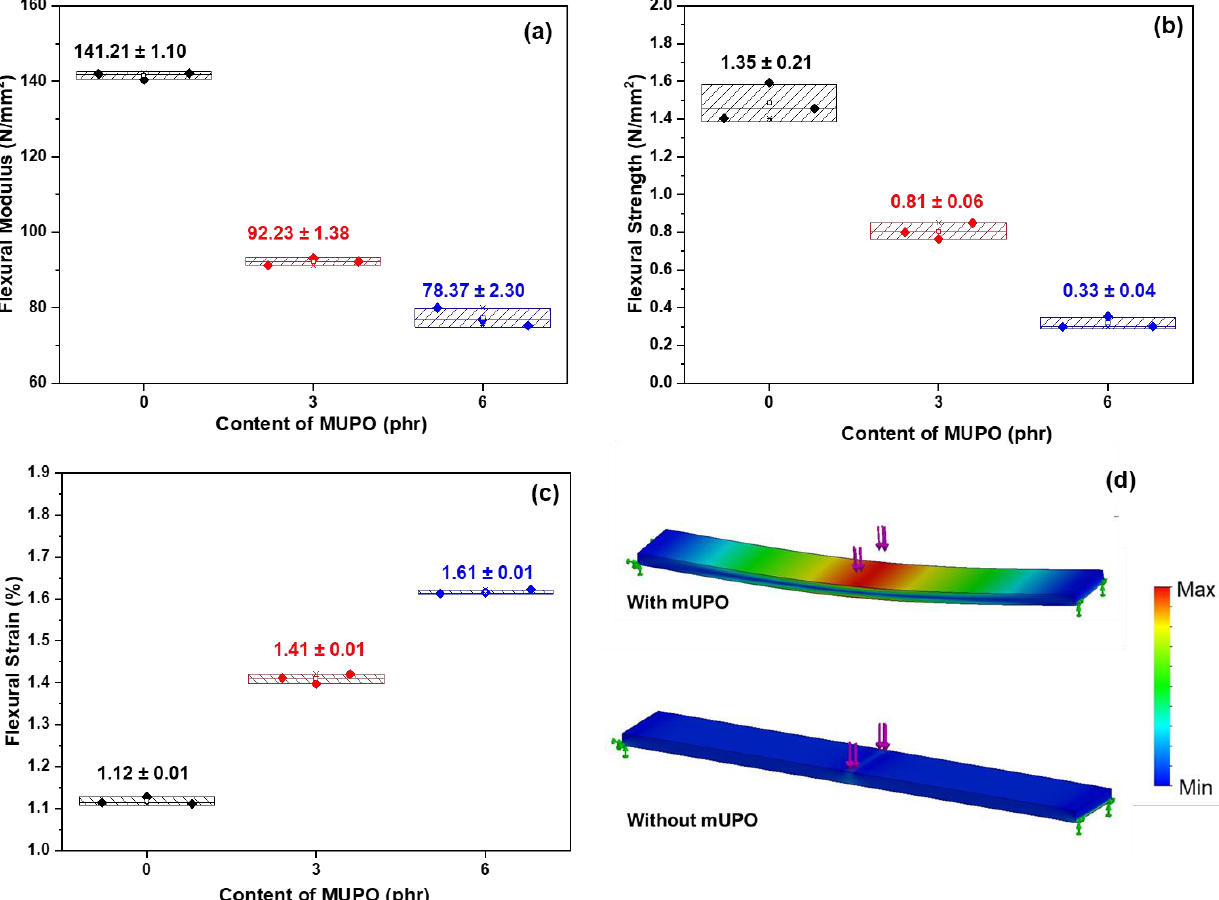
Figure 5. The results of ( a ) flexural modulus, ( b ) flexural strength, ( c ) flexural strain, and ( d ) simulation of non-glutinous starch foam with various mUPO content — 0, 3, and 6 phr. The flexural modulus of non-glutinous starch foam with mUPO contents of 0, 3, and 6 phr is 141.21, 92.23, and 78.37 N/mm 2 , respectively. Similarly, the flexural strength of starch foam with varying mUPO content of 0, 3, and 6 phr is 1.35, 0.81, and 0.33 N/mm 2 .